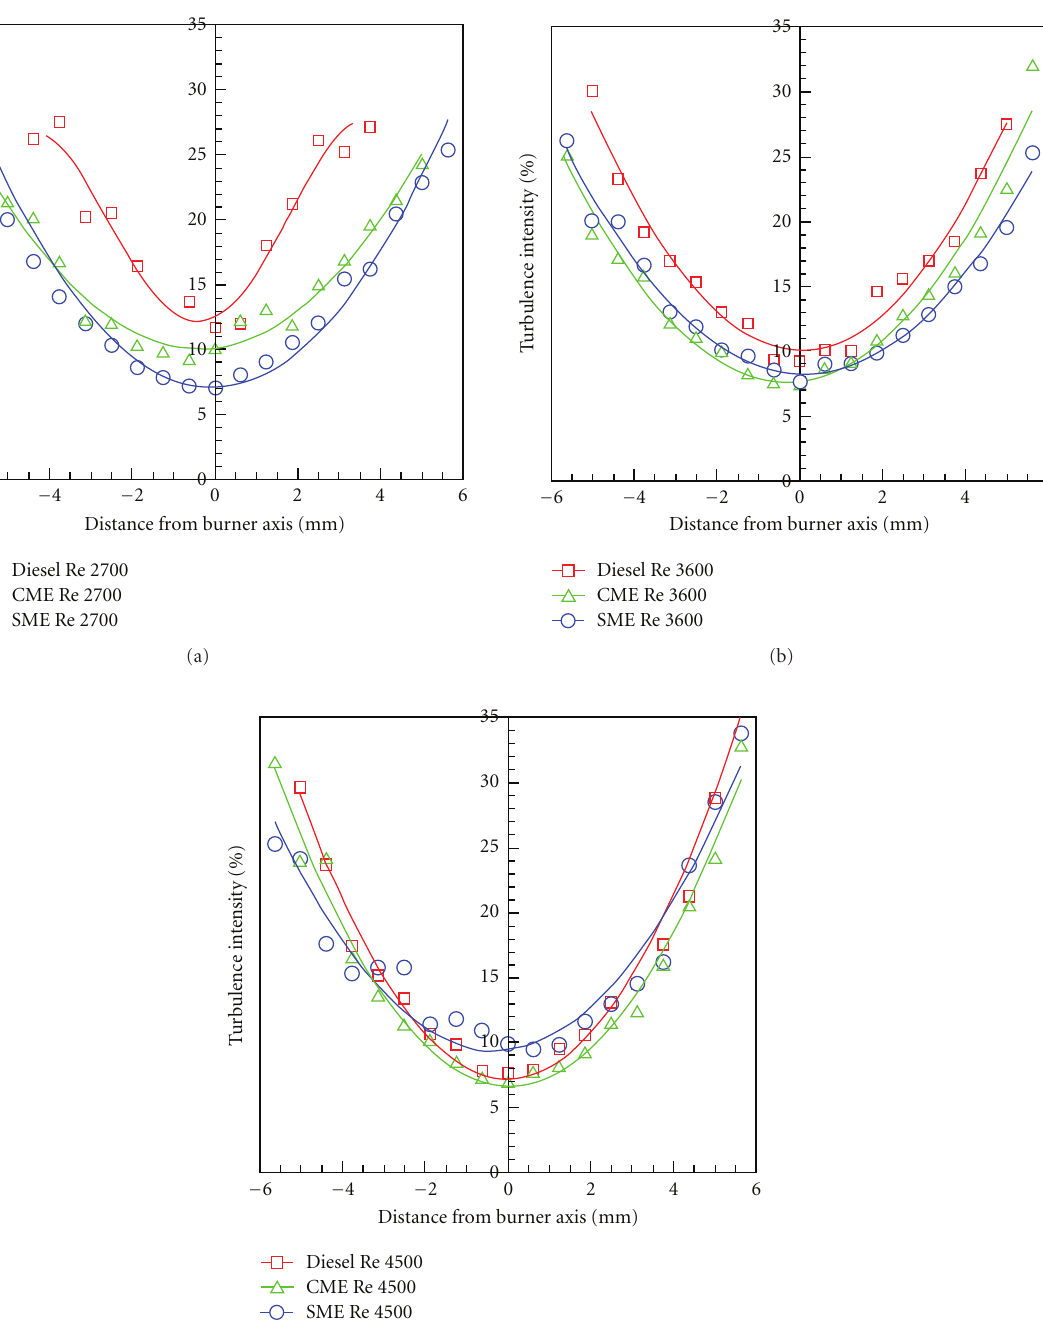
Figure 6: Axial velocity turbulence intensity profiles at the burner